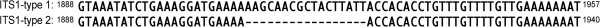
Comparison of the Oxyspirura petrowi type 1 and type 2 ITS1 sequences at the insertion/deletion site. Their sequences are available at GenBank database with accession numbers [GenBank:KF110799] and [GenBank:KF110800].